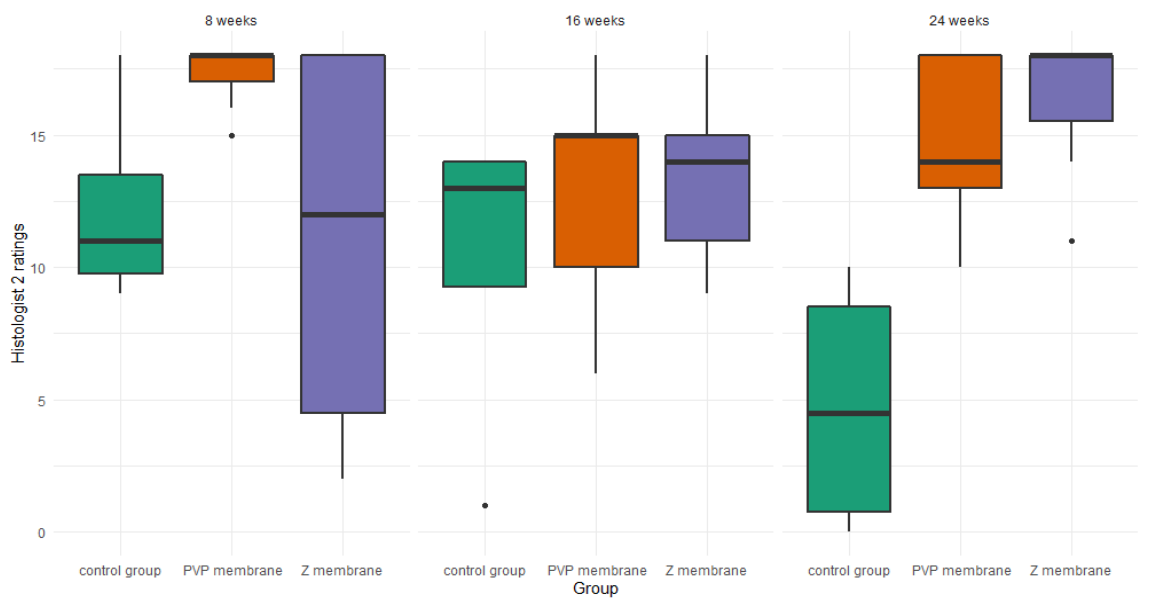
Figure 8. Boxplot of histologist 2 ratings, in the three studied groups, at three time points.